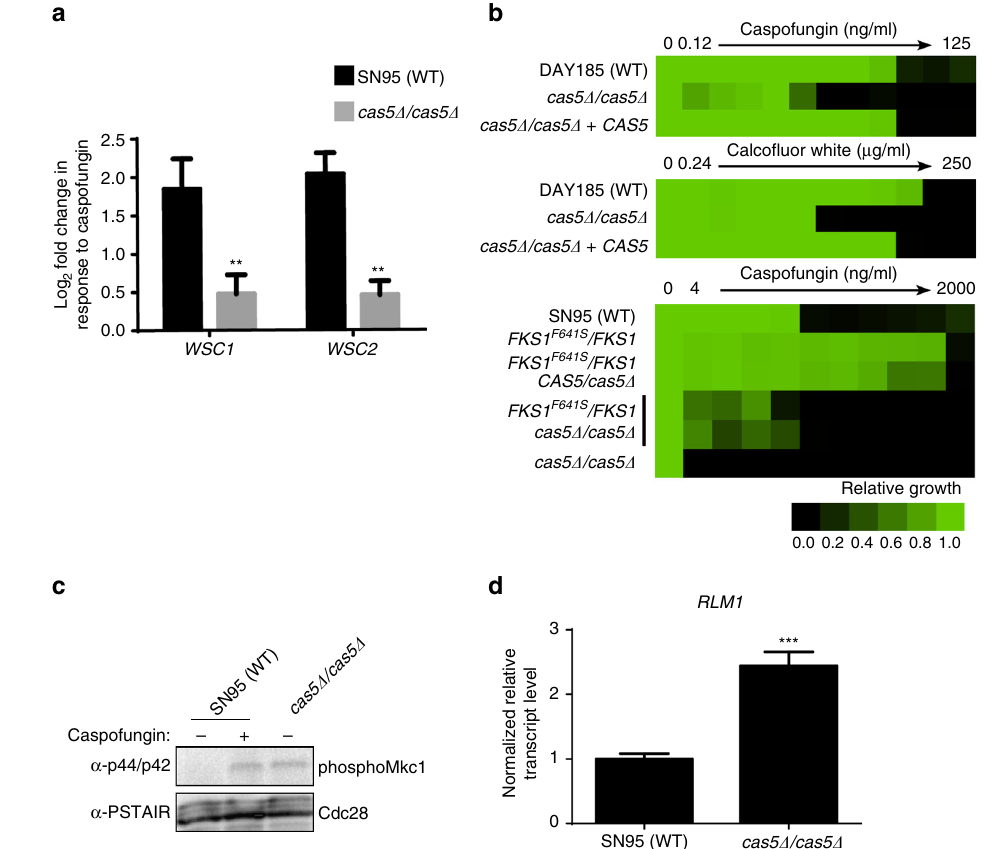
Fig. 3 Cas5 regulates cell wall stability under basal and cell wall stress conditions. a WSC1 and WSC2 , transmembrane sensors that respond to cell wall perturbation, require Cas5 for upregulation in response to caspofungin. The transcript level of WSC1 and WSC2 were monitored by qRT-PCR and normalized to TEF1 . Plotted are the log 2 fold-changes in transcript levels upon caspofungin treatment relative to untreated conditions in both the wildtype ( black ) and cas5 Δ /cas5 Δ mutant ( gray ). Error bars represent standard deviation (s.d.) from the mean of triplicate samples. Signi fi cance was measured with an unpaired t test in GraphPad Prism (** P < 0.01). b Cas5 is required for tolerance and resistance to cell wall stress. Caspofungin or calco fl uor